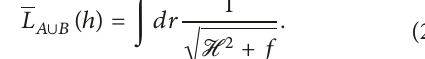
Figure 5: Relation between 𝜃 0 and 𝑟 𝑚𝑖𝑛 for the case 𝑄 =0.5.